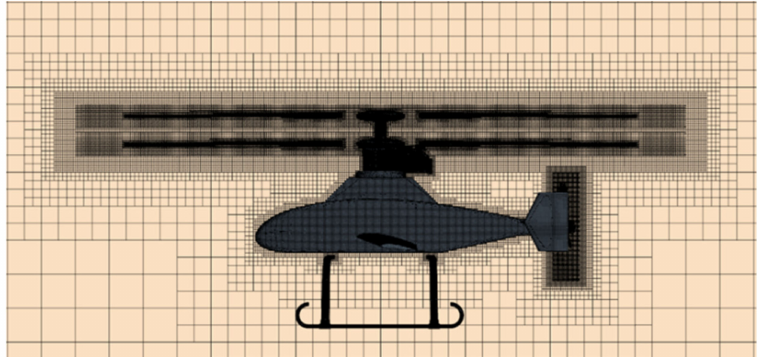
Figure 4. Compound coaxial helicopter motion nested mesh system assembly diagram.